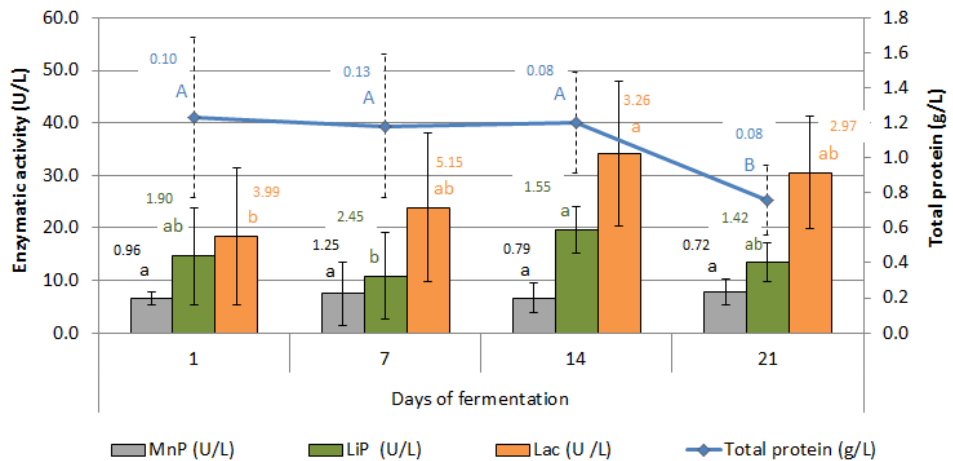
Figure 7. Enzymatic activity (U/L) of manganese peroxidase (MnP), lignin peroxidase (LiP), and laccase (Lac) and total protein concentration (g/L), in SSF with P. ostreatus for 21 days. Differences were assessed by ANOVA with Tukey mean comparison test. Graph bars with different superscripts (a, b) indicate significant differences between fermentation days ( p < 0.05). Capital letters on the secondary axis of the total protein indicate significant differences between the days of fermentation ( p < 0.05). Above the superscripts of the bars and the capital letters of the secondary axis, the standard error of the mean is indicated.